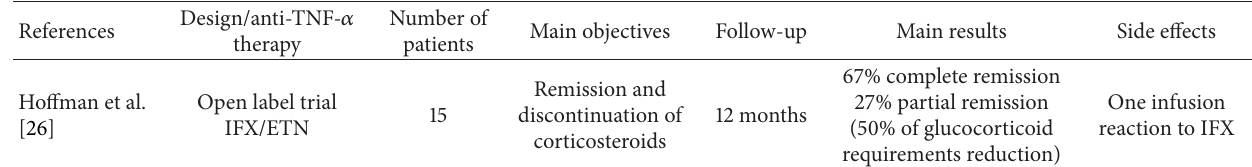
Table 2: Open label trial performed in